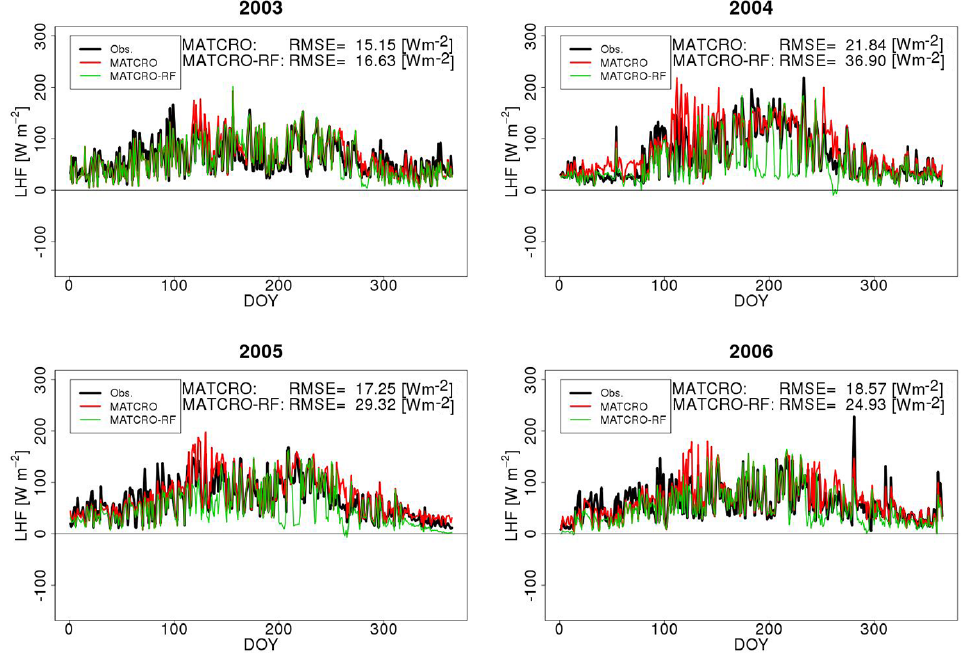
Figure 15. Comparison of daily LHF between observations and simulations by MATCRO and MATCRO-RF. DOY indicates the number of days from 1 January.